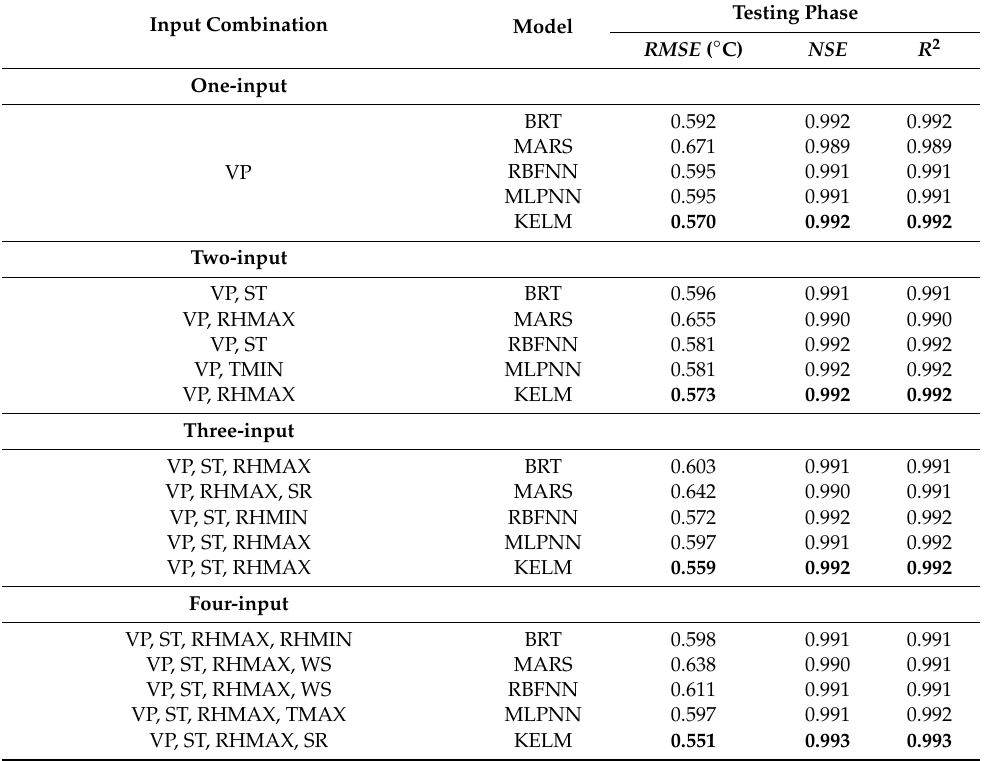
Table 4. Results of the best BRT, MARS, RBFNN, MLPNN, and KELM models for estimating daily T dew at UC Riverside